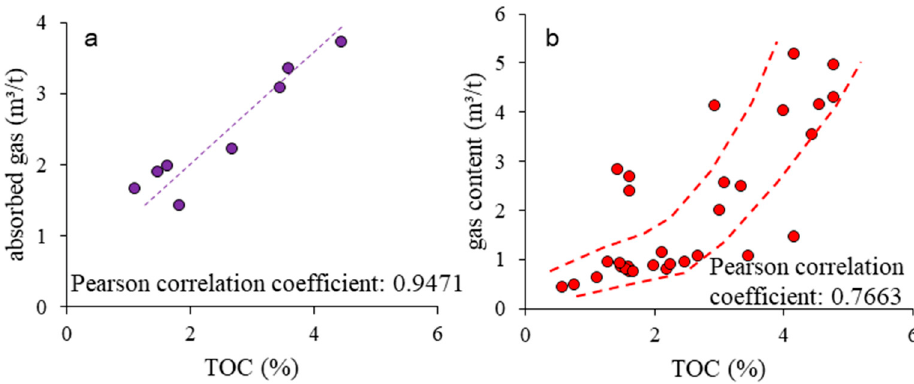
Figure 12. Relationship between ( a ) absorbed gas and total organic carbon (TOC), and ( b ) gas content and TOC of Wufeng-Longmaxi Formation in Well